Question: Produce a descriptive caption suitable for publication.
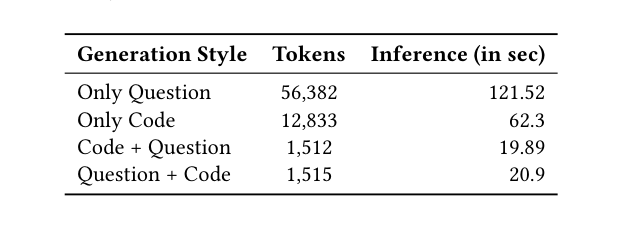
Answer: shows how the alignment (logits from the classification model) slightly degrades as more insights are generated. We ob- served that the complexity of the insights increases as they were generated, which increases the potential for semantic alignment errors. For example, an initial insight generated for the table in Figure 1 is Which year had the highest number of championships?